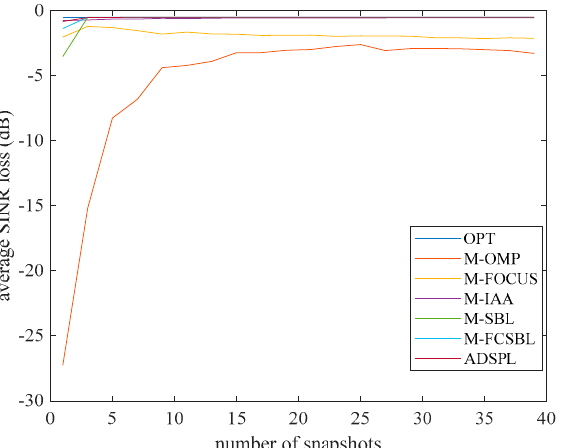
Figure 7. Average SINR loss to the number of snapshots in ideal case.